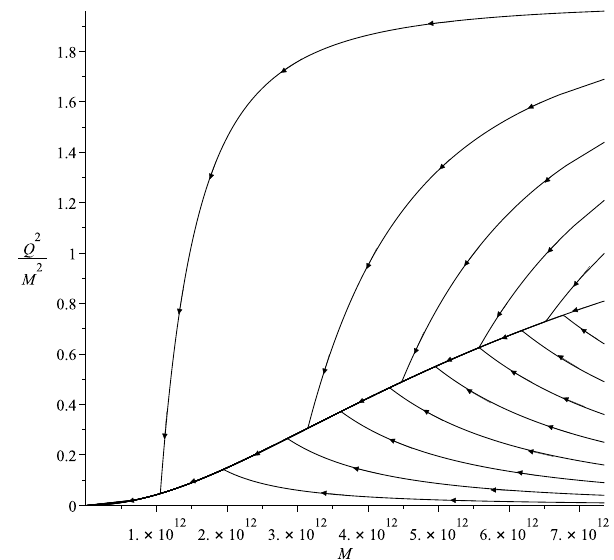
Figure 6 . GHS black holes avoid becoming extremal under Hiscock-Weems model, after the charged loss rate is modi(cid:12)ed by eq. (4.1), with C = 2; cf. (cid:12)gure 2. Arrows denote the direction of evolution.